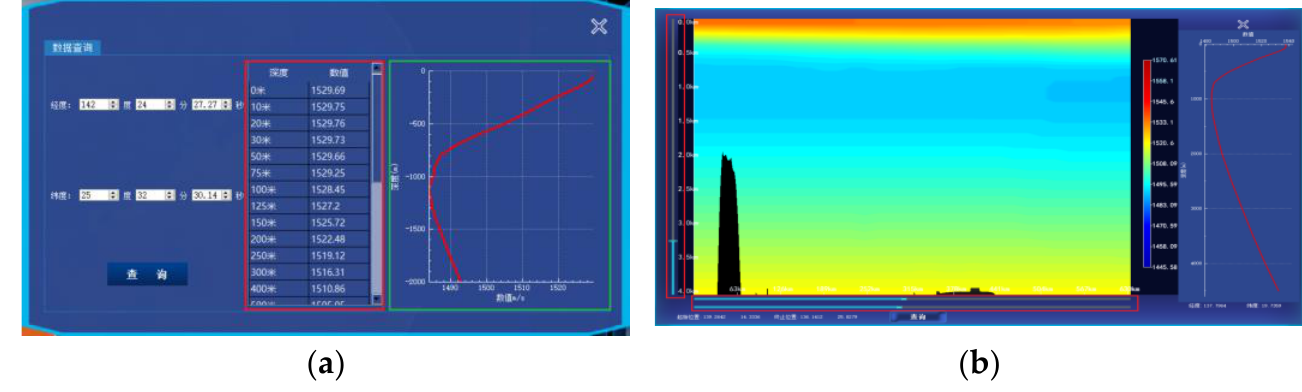
Figure 15. Point query ( a ) and line query ( b ) renderings.